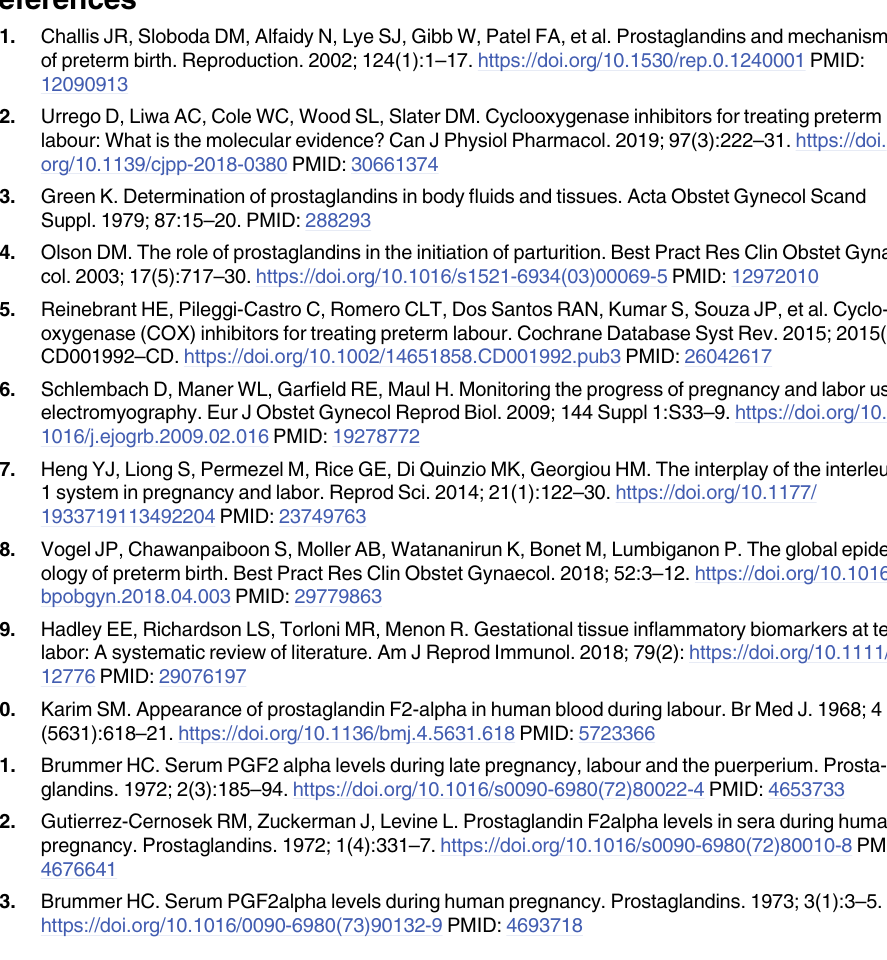
S3 Table. Quality assessment